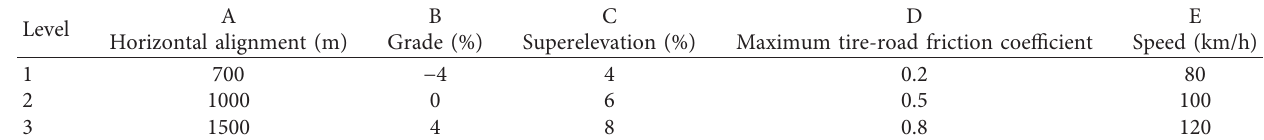
Table 5: Factors and level table [40].